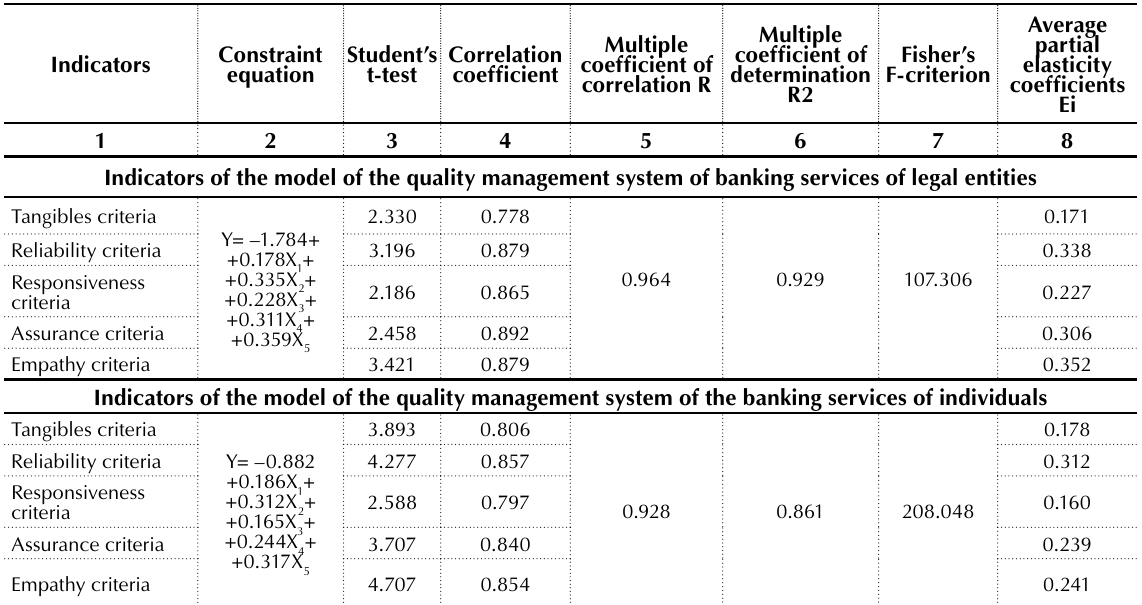
Table 3. The main indicators of the model for assessing banking services quality of two groups of